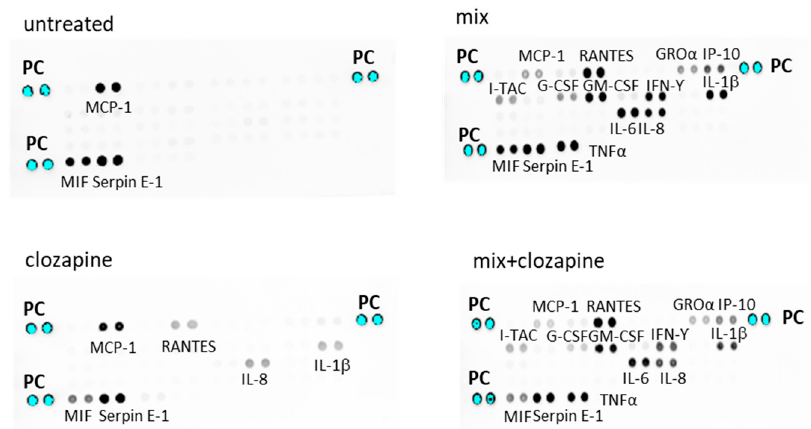
Figure 1. Effects of clozapine on the protein production of inflammatory mediators. A172 cells were treated with either clozapine (10 µM) alone, or the cytokine mix, or the cytokine mix with clozapine. The culture medium was collected 24 h after stimulation and analyzed using a human cytokine array. PC—positive control. The figure shows a representative blot of one of two similar experiments.